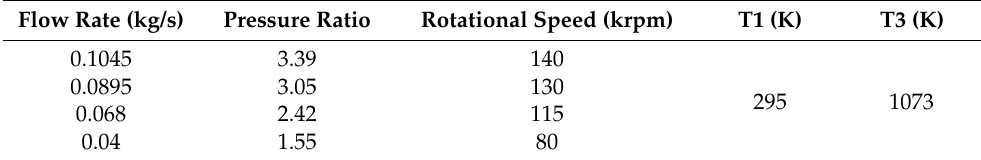
Table 7. Heat loss in the turbine and compressor.